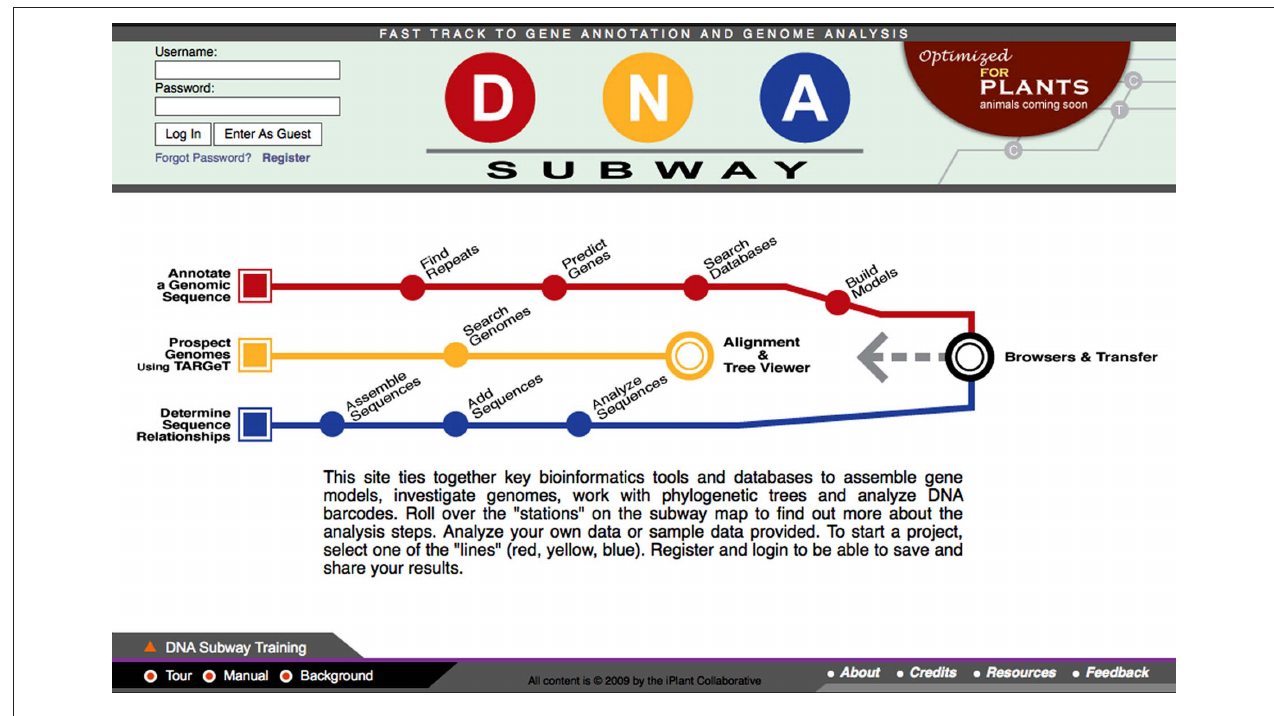
FIgure 3 | The DNA Subway. The DNA Subway is an Educational DE, a simplified workflow for gene annotation and comparison. The subway lines are the Red Line (predicts and annotates genes in contigs less than 150 kb), the Yellow Line (identifies homologs in other sequenced genomes), and the Blue Line (supports phylogenetics analysis and DNA barcode analysis). Additional “lines” are under development as new tools are integrated into the iPlant CI that can be consumed by a web-based